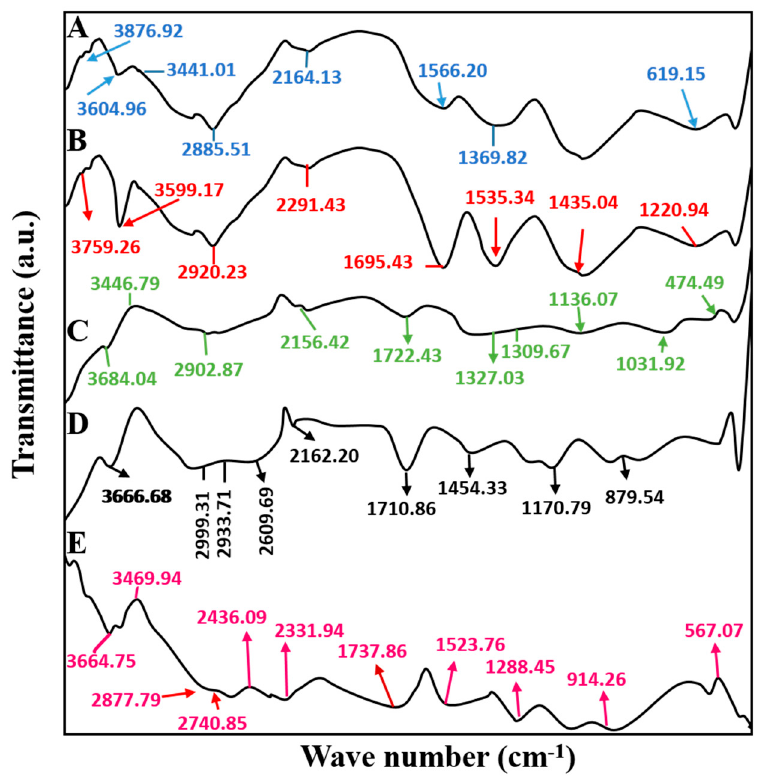
Figure 3. FTIR Spectra of (A) chitosan, (B) mucin, (C) tofacitinib, (D) unloaded microparticles, (E) drug-loaded MU-CHI-Co-Poly (MAA) hydrogel